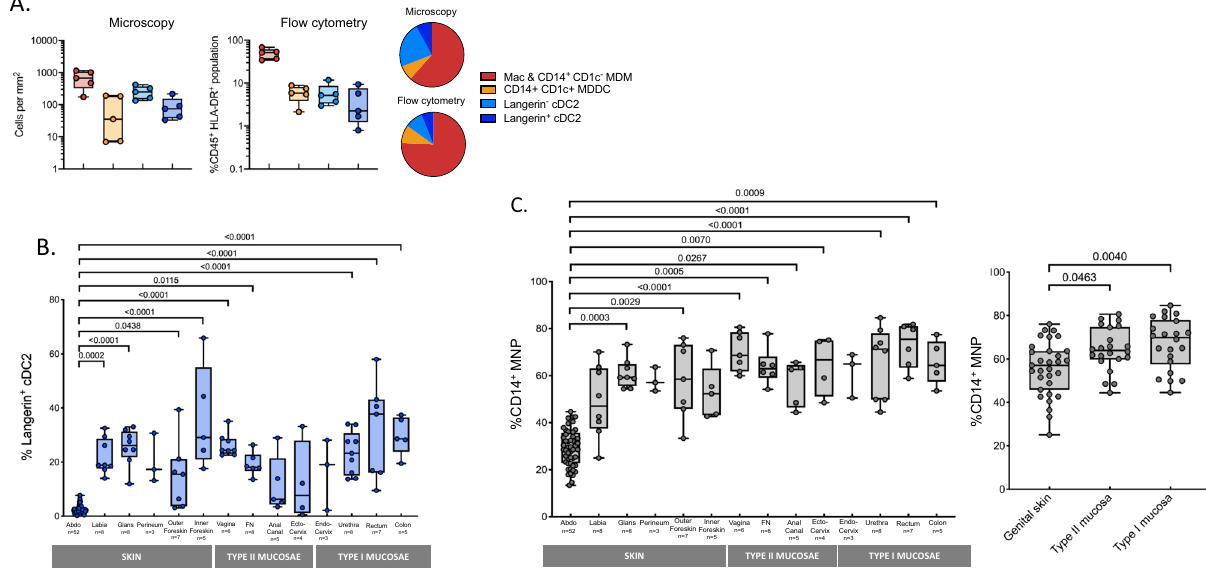
Fig. 2 Proportion of cDC2 and CD14-expressing mononuclear phagocytes in human sub-epithelial tissue. A Using fl uorescent microscopy the proportion of sub-epithelial MNP subsets were quanti fi ed in inner foreskin ( n = 5) to a depth of 60 µ m from the basement membrane and compared to the proportion quanti fi ed using fl ow cytometry ( n = 5). Plotted as box and whisker plots, box representing the upper and lower quartile, central line representing the median, the whiskers the minimum and maximum of each cell subset and each donor represented by an individual dot. Pie charts show the mean proportion of MNP subsets using both quanti fi cation methods. Combined CD14 + CD1c − monocyte-derived macrophages (MDM) and macrophages (Mac) (red), CD14 + CD1c + monocyte-derived dendritic cells (MDDC) (orange), langerin - cDC2 (light blue) and langerin + cDC2 (dark blue). B The proportion of langerin + cDC2 across the human anogenital/colorectal tissue plotted as box and whisker plots, box representing the upper and lower quartile, central line representing the median, the whiskers the minimum and maximum of each tissue sample and each donor represented by an individual dot. Statistics were generated using the Kruskal – Wallis test: two-tailed Dunn ’ s multiple comparisons with adjusted P values shown. (abdominal tissue (Abdo) = 52, labia = 8, glans penis = 8, perineum = 3, outer foreskin = 7, inner foreskin = 5, vagina = 6, fossa navicularis (FN) = 8, anal canal = 5, ectocervix = 4, endocervix = 3, penile urethra = 8, rectum = 7, colon = 5). C The proportion of CD14 + mononuclear phagocytes (macrophages, CD14 + CD1c − cells, CD14 + CD1c + cells) across the human anogenital/colorectal tract. Left: looking at individual anogenital/colorectal tissue (abdominal tissue (Abdo) = 52, labia = 8, glans penis = 8, perineum = 3, outer foreskin = 7, inner foreskin = 5, vagina = 6, fossa navicularis (FN) = 8, anal canal = 5, ectocervix = 4, endocervix = 3, penile urethra = 8, rectum = 6, colon = 5), right: pooled data for genital skin (labia, glans penis, perineum, outer foreskin, inner foreskin; n = 31), type II mucosae (vagina, fossa navicularis, anal canal, ectocervix; n = 22) and type I mucosae (endocervix, penile urethra, rectum, colon n = 22) plotted as box and whisker plots, box representing the upper and lower quartile, central line representing the median, the whiskers the minimum and maximum of each tissue sample and each donor represented by an individual dot. Statistics as described above for B